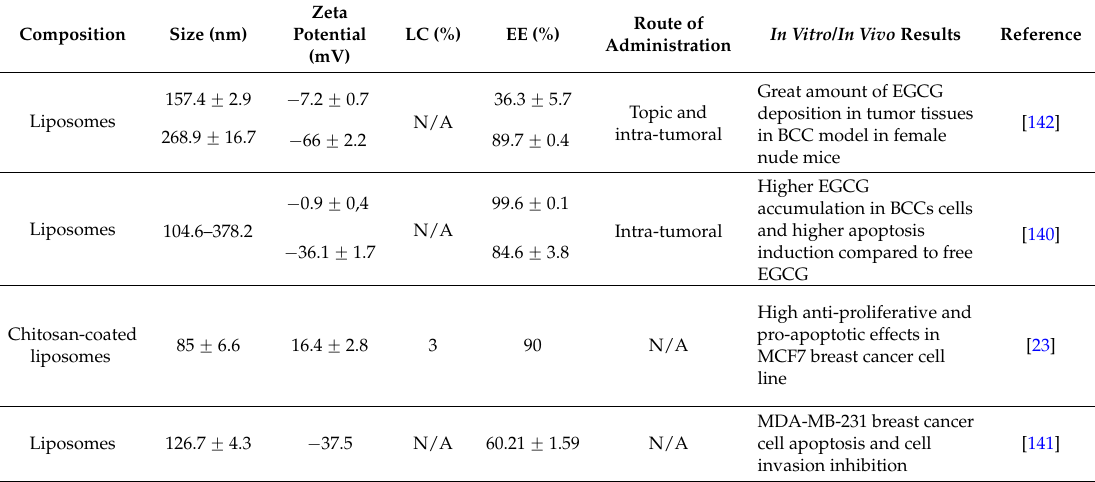
Table 3. Liposomes used as EGCG nanocarriers for cancer